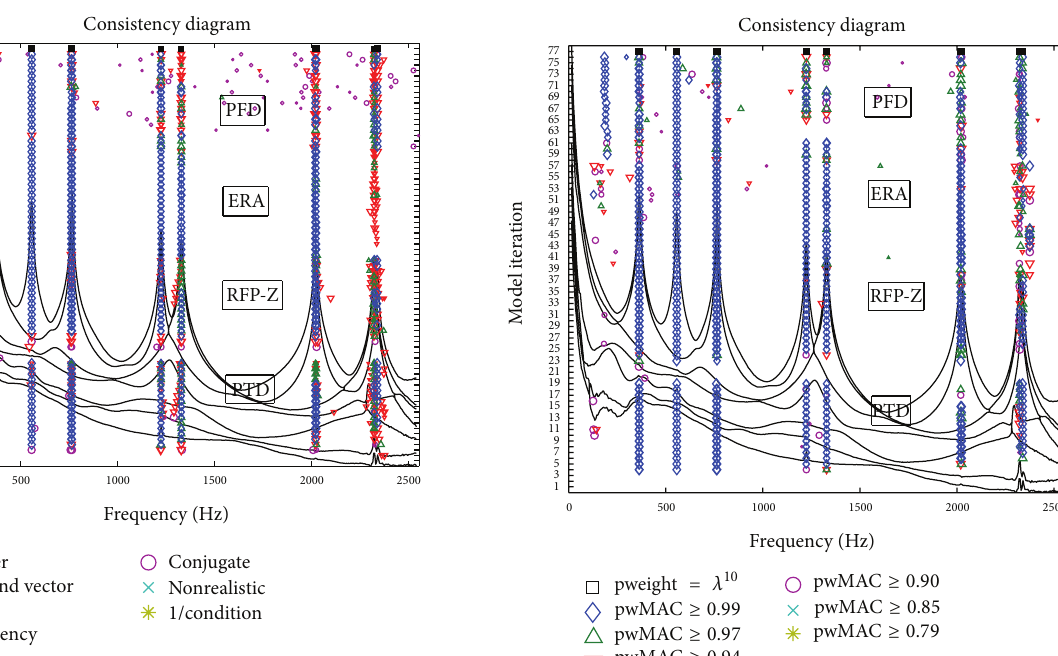
Figure 3: Extended consistency diagram, conventional version. Figure 4: Extended consistency diagram, pole-weighted MAC